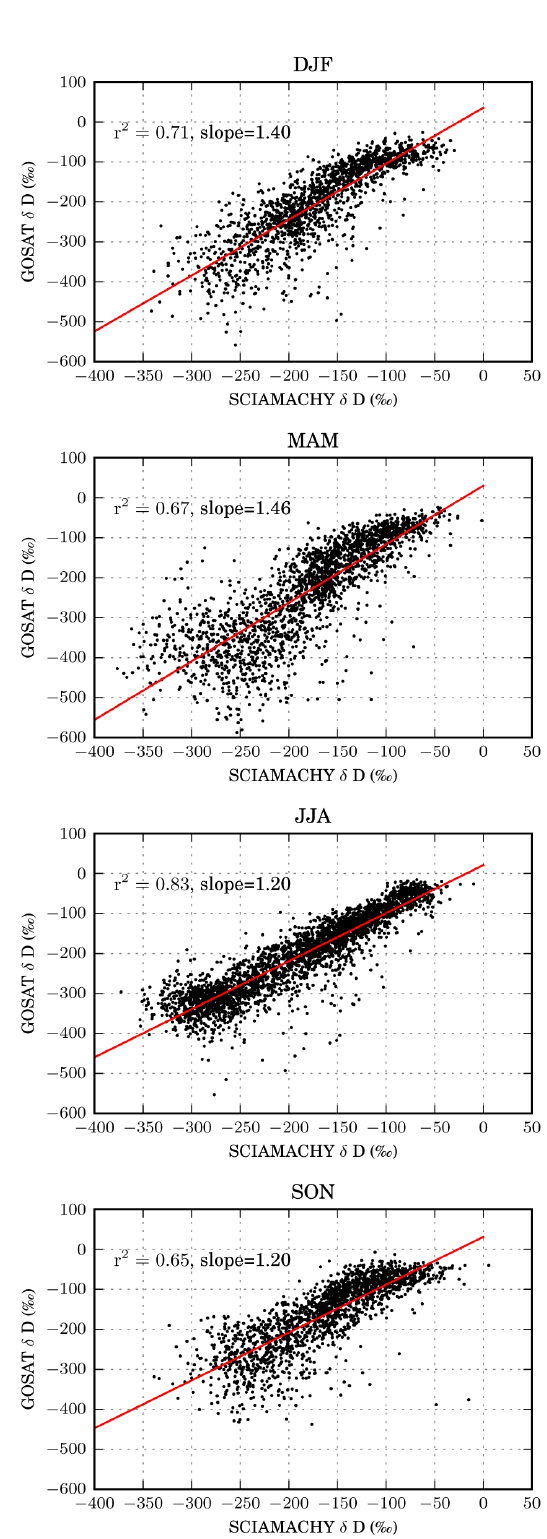
Fig. 11. Scatter plots of SCIAMACHY (2003–2005) and